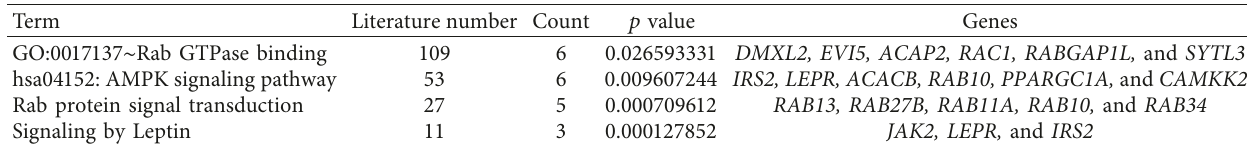
Table 2: Four terms related to